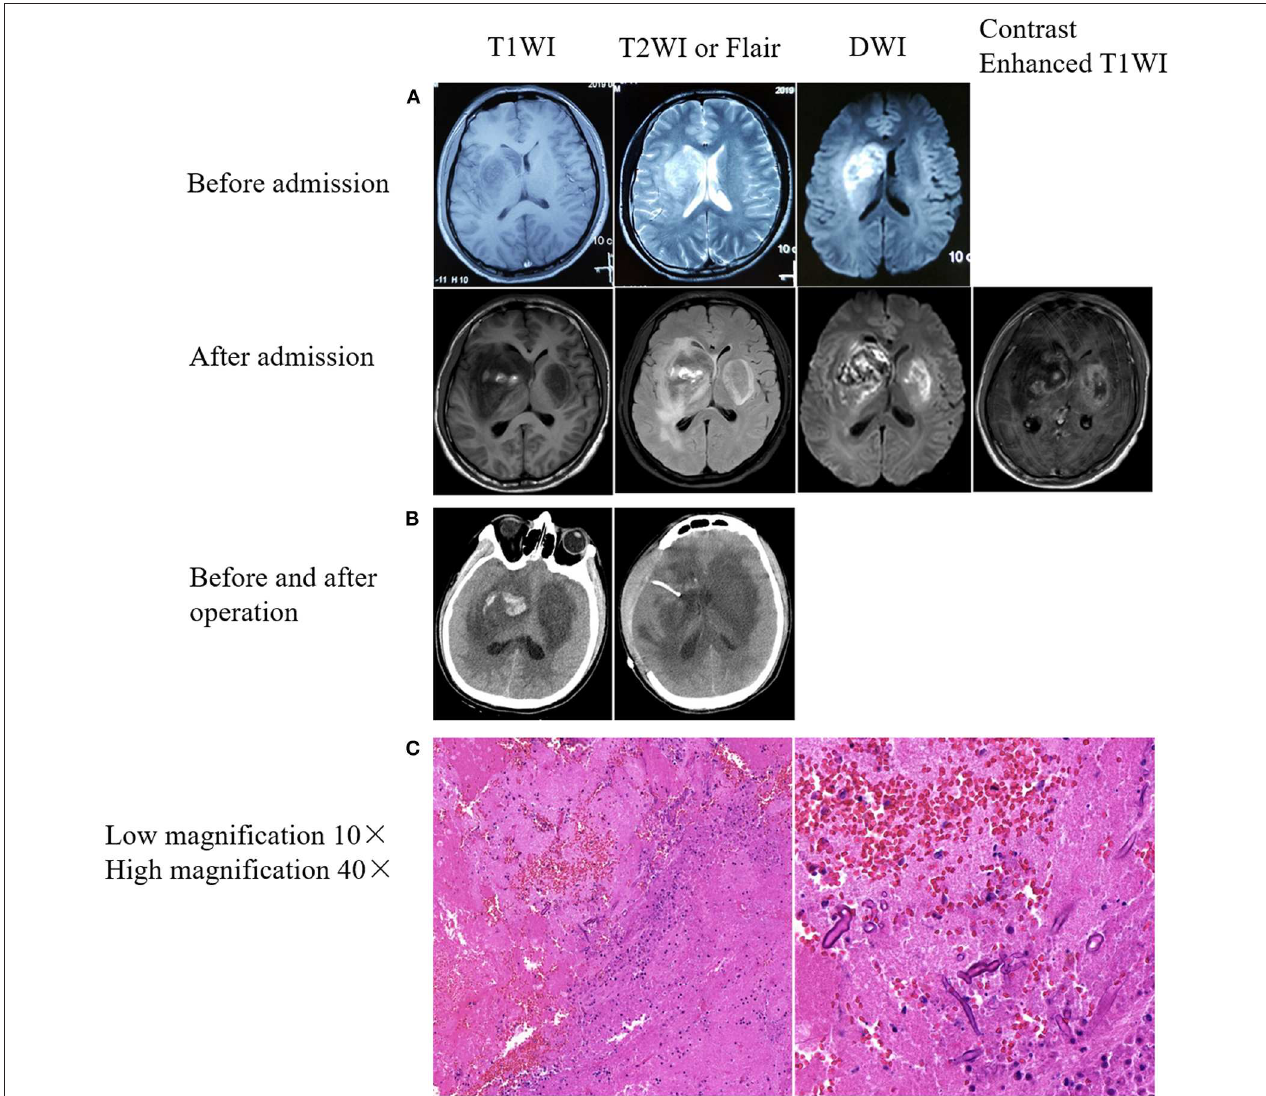
FIGURE 1 | Brain imaging and immunohistochemical results. (A) Rapid progressive damage in the bilateral basal ganglia. Upper: Right basal ganglia lesion with patchy abnormal signals before admission. Lower: The bilateral basal ganglia showed patchy abnormal signals after admission. Bilateral basal ganglia lesions with hemorrhage on the right side. (B) Mixed density shadow in the bilateral basal ganglia with peripheral parenchymal edema and postoperative resection of right basal ganglia lesions. (C) Pathological results from the brain tissues of lesions in the right basal ganglia. Hematoxylin-eosin staining. Fungal spores and hyphae were observed in a small amount of necrotic brain